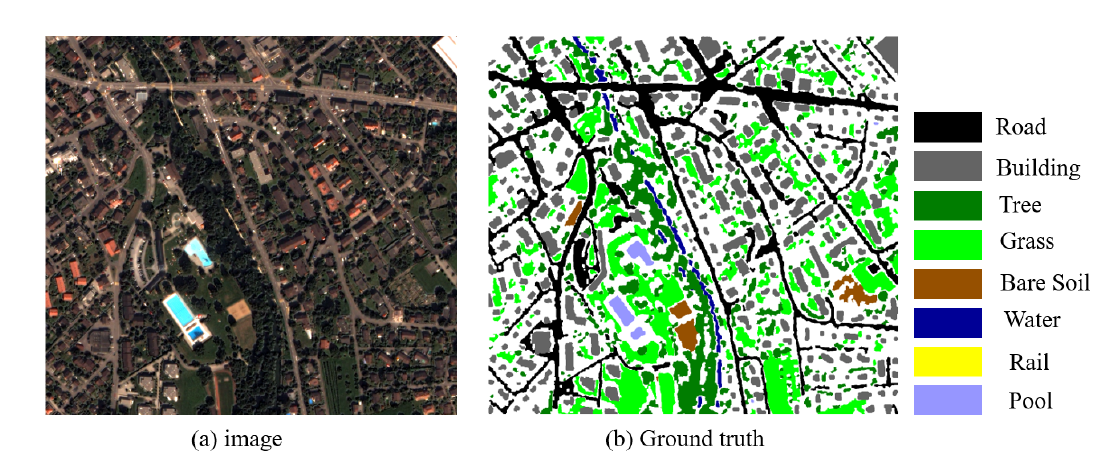
Figure 9. Example from the Zurich